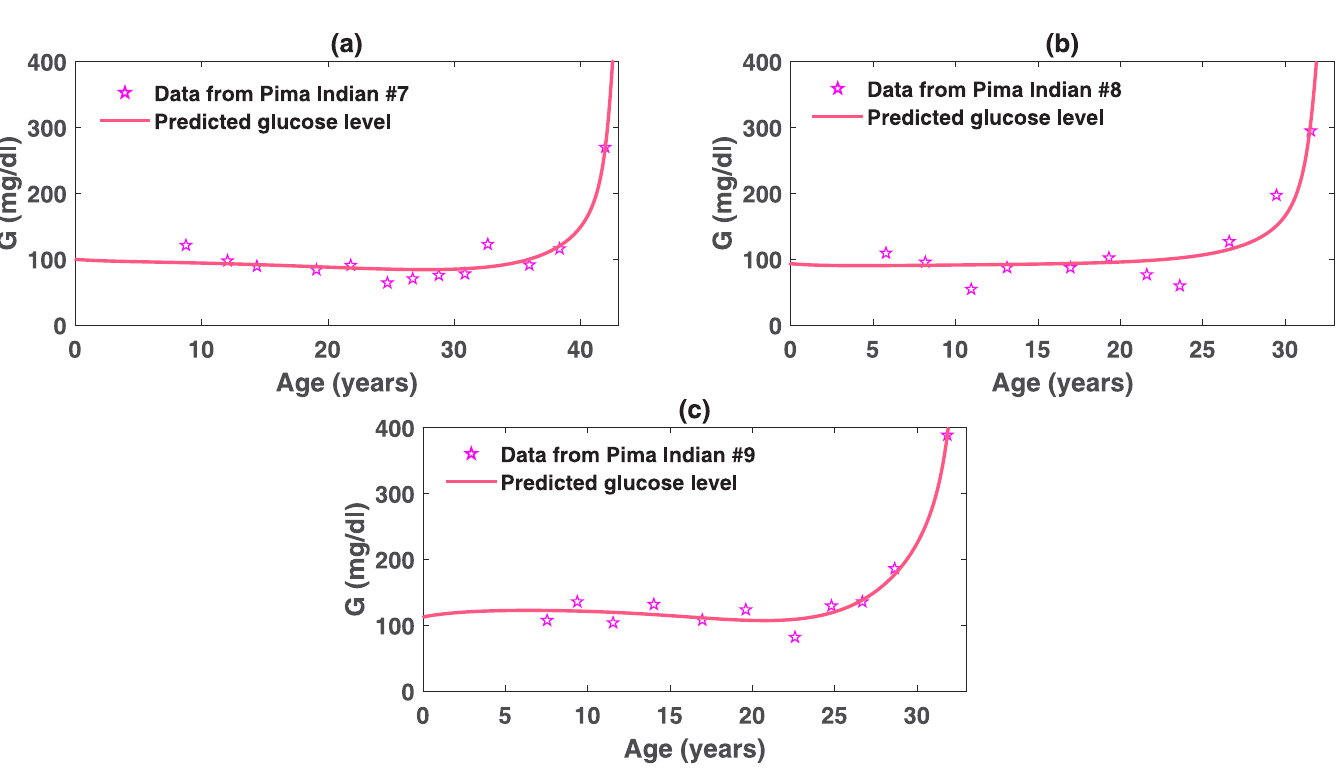
Fig 9. Obesity-related diabetes model fit to plasma glucose data for Pima Indian #7–#9. These data exhibit waveringly trends before the outbreak.